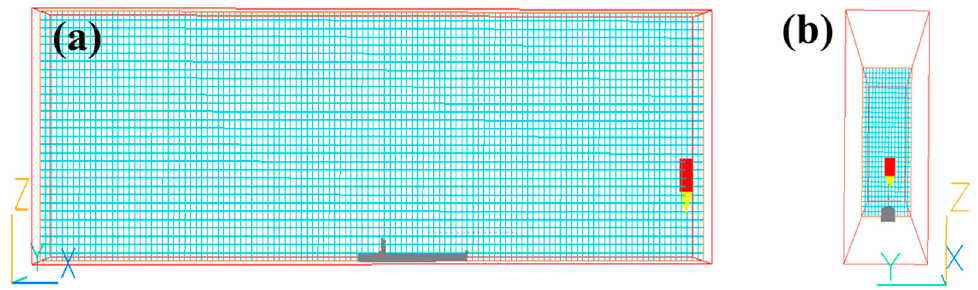
Figure 1. The ship model, the domain, and the grids in the CFD model: ( a ) model setting on the X–Z plane; ( b ) model setting on the Y–Z plane.